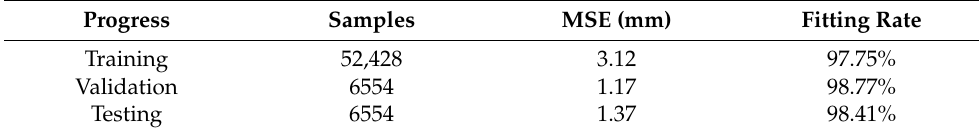
Table 3. Performance of machine learning.